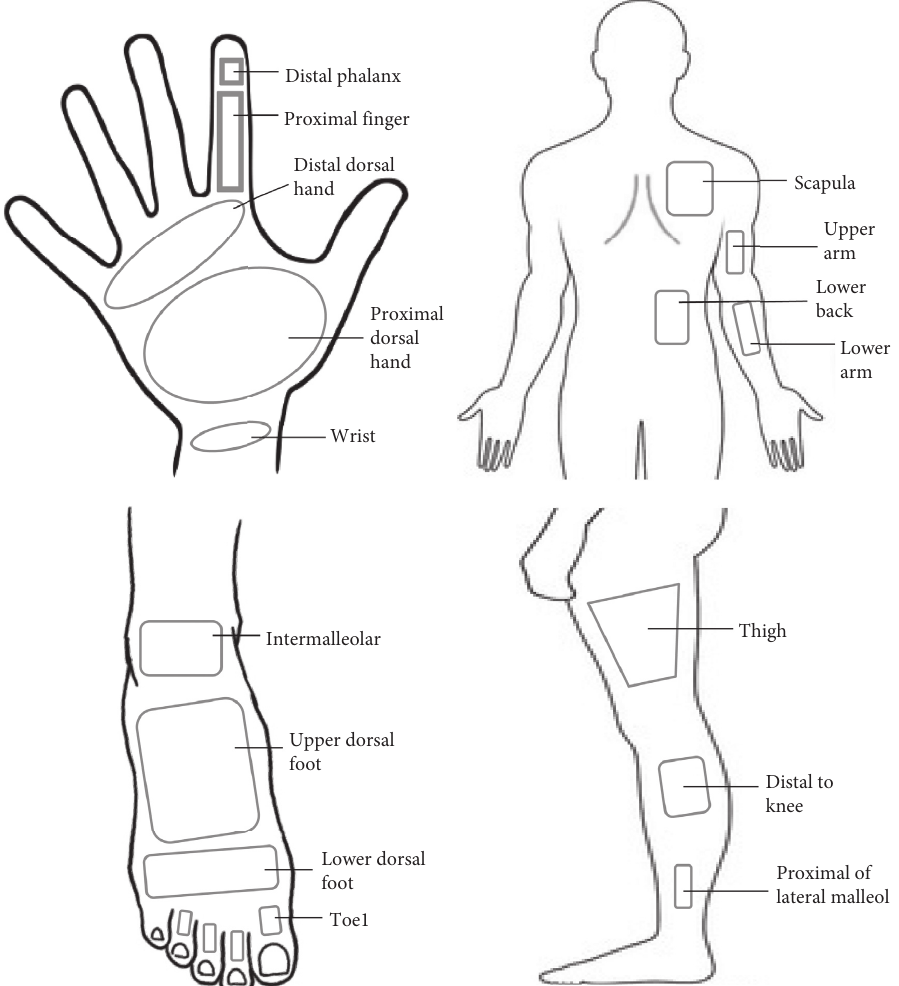
Figure 1: Schematic illustration of analyzed regions of interest (ROIs). Proportions are not